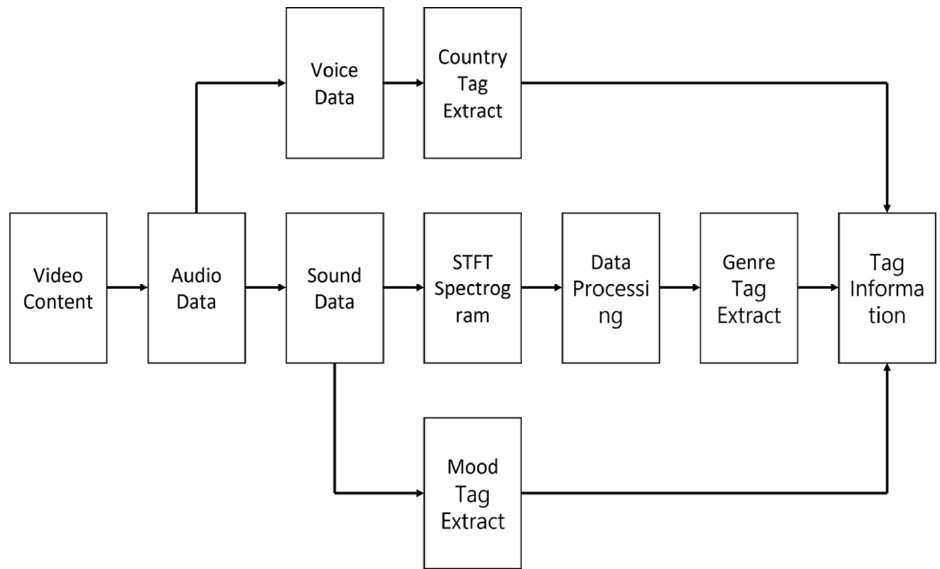
Figure 2. Full system configuration diagram.